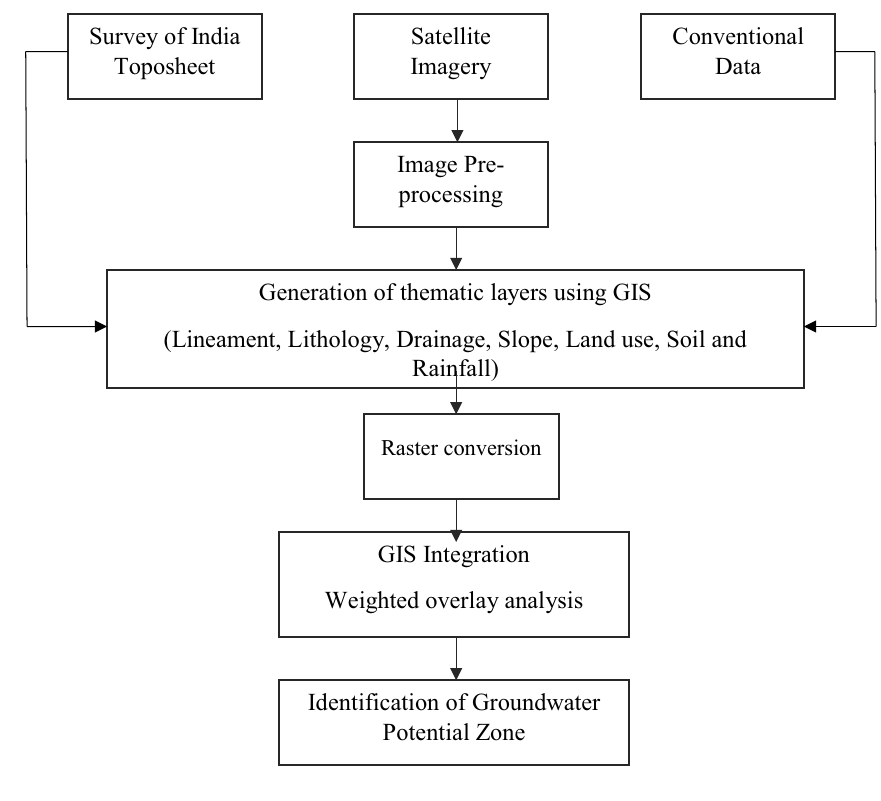
Fig. 2 The interrelationship between the multi-influencing factors concerning the ground- water potential